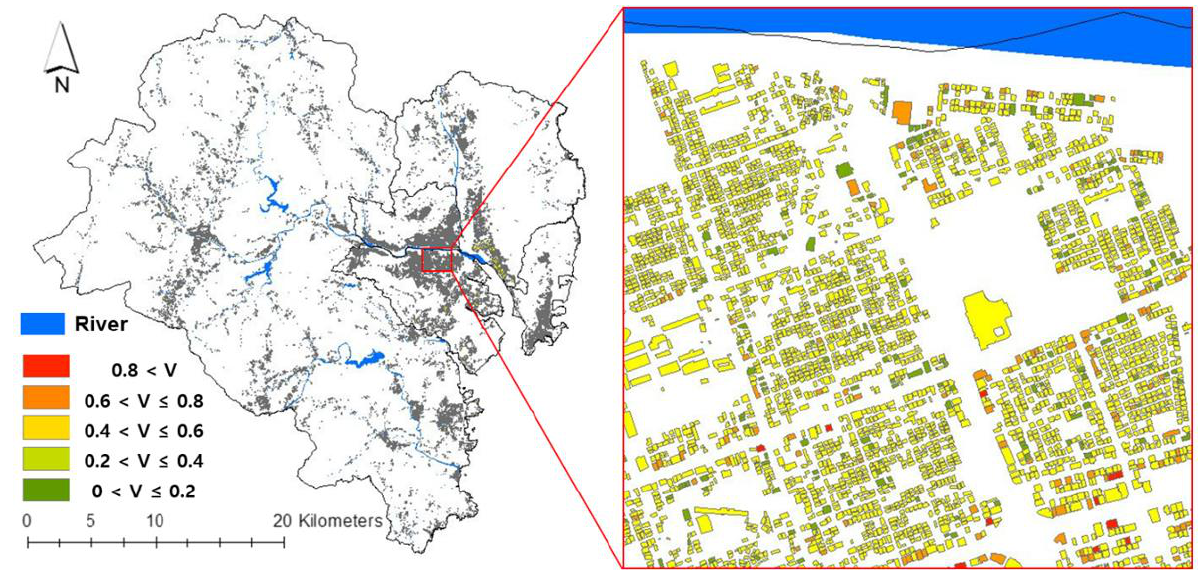
Figure 6. Vulnerability analysis for urban flood building.